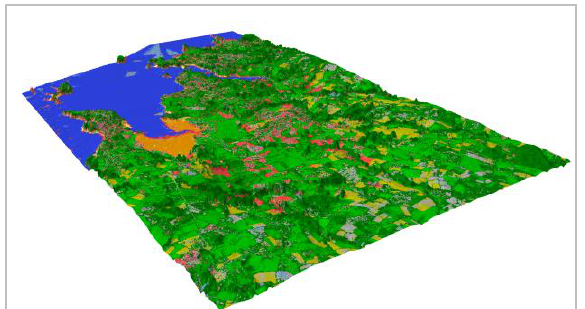
Figure 9. Best classification score (BGR+DSM+NIR with the ML algorithm) draped on the DSM, both derived from a Pleiades-1